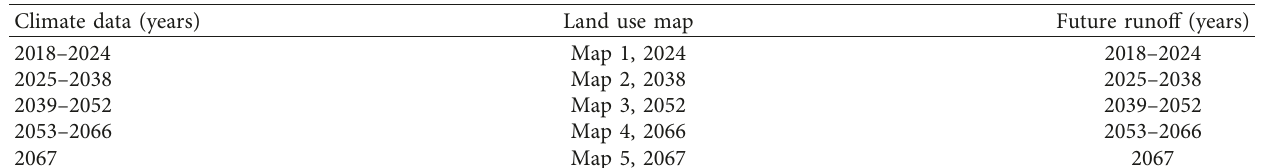
Table 2: Future time periods.